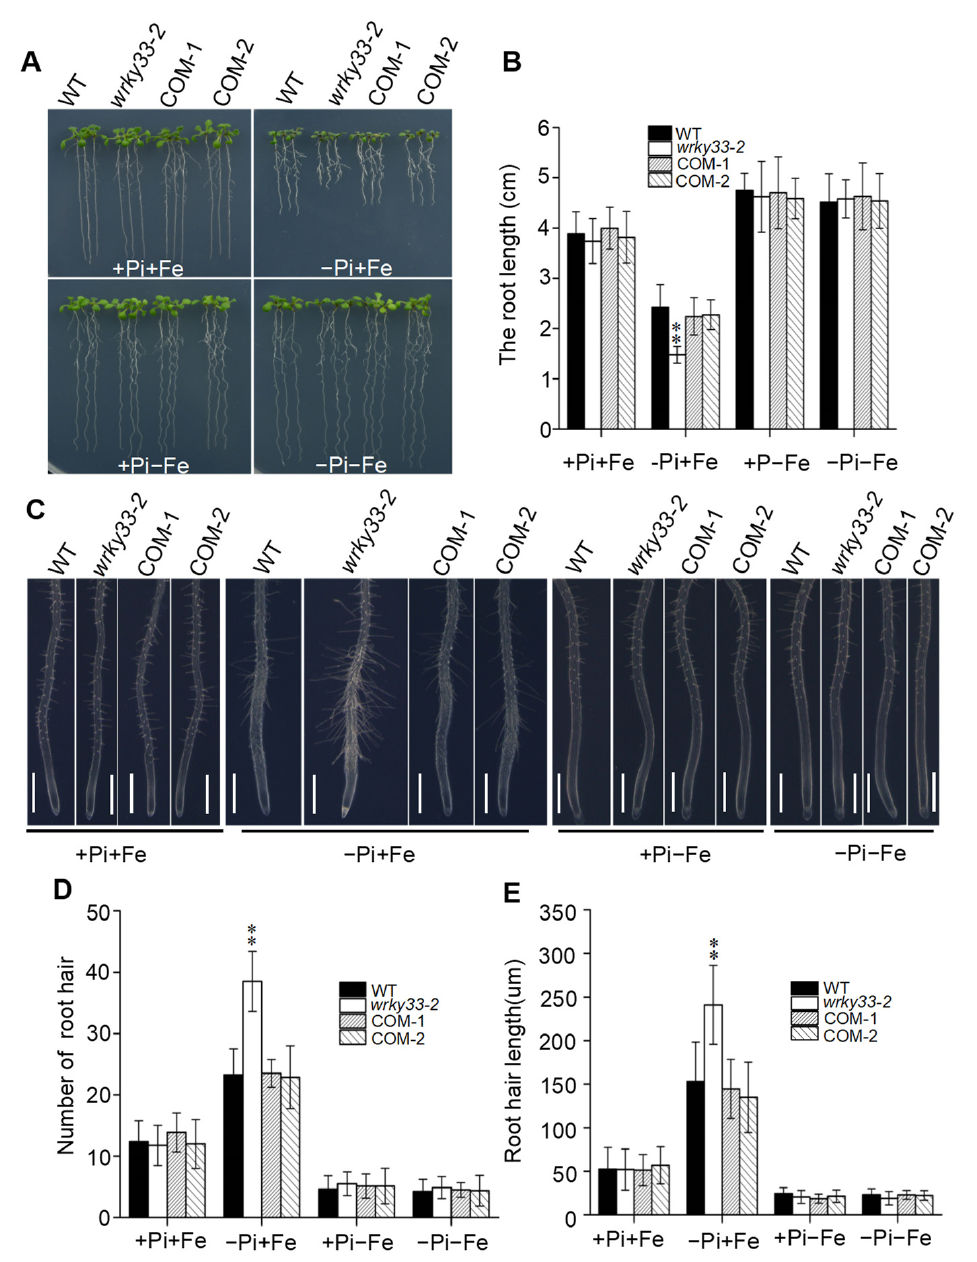
Figure 4. WRKY33 regulates the low Pi signaling that intersects with Fe signaling. ( A ) The growth phenotype of wild-type (WT) and mutant seedlings. Four-day-old seedings were transferred to +Pi +Fe, − Pi+Fe, +Pi − Fe, and − Pi − Fe medium for six days. ( B ) The statistical analysis of the primary root length as indicated in ( A ). Data are means ± SD from three independent experiments ( n = 15; n represents the number of samples). ( C ) Root hair growth in WT, wrky33-2 , and COM-1 and COM-2 seedlings. Four-day-old seedings were transferred to +Pi+Fe, –Pi+Fe, +Pi − Fe, and − Pi − Fe medium for three days. The experiments were repeated three times with similar results. Bar = 200 µ M. ( D , E ) Root hair number ( D ) and root hair length ( E ) as indicated in ( C ). The hair density and length measured within a 1 mm zone in the root starting from the root tip. Data are means ± SD from three independent experiments ( n = 15). Asterisks in ( B , D , E ) indicate a significant difference from the WT (Tukey’s test; **, p <0.01).